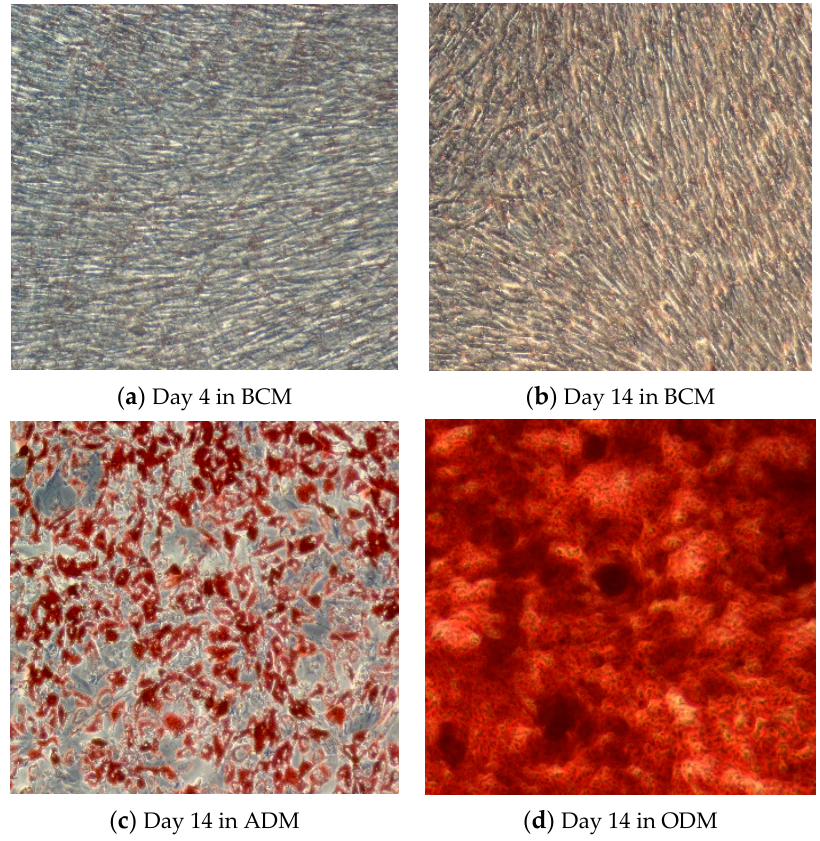
Figure 1. Light microscopy images (10x magnification, using inverted microscope, Zeiss, Oberkochen, Germany) of ( a ) AT-derived hMSCs after 4 days, and ( b ) 14 days of cultivation in basal culture media (BCM). ( c ) Oil red staining illustrating adipogenic differentiation of AT-derived hMSCs after 14 days of cultivation in adipogenic differentiation media (ADM). ( d ) Alizarin red staining illustrating osteogenic differentiation of AT-derived hMSCs after 14 days of cultivation in osteogenic differentiation media (ODM).